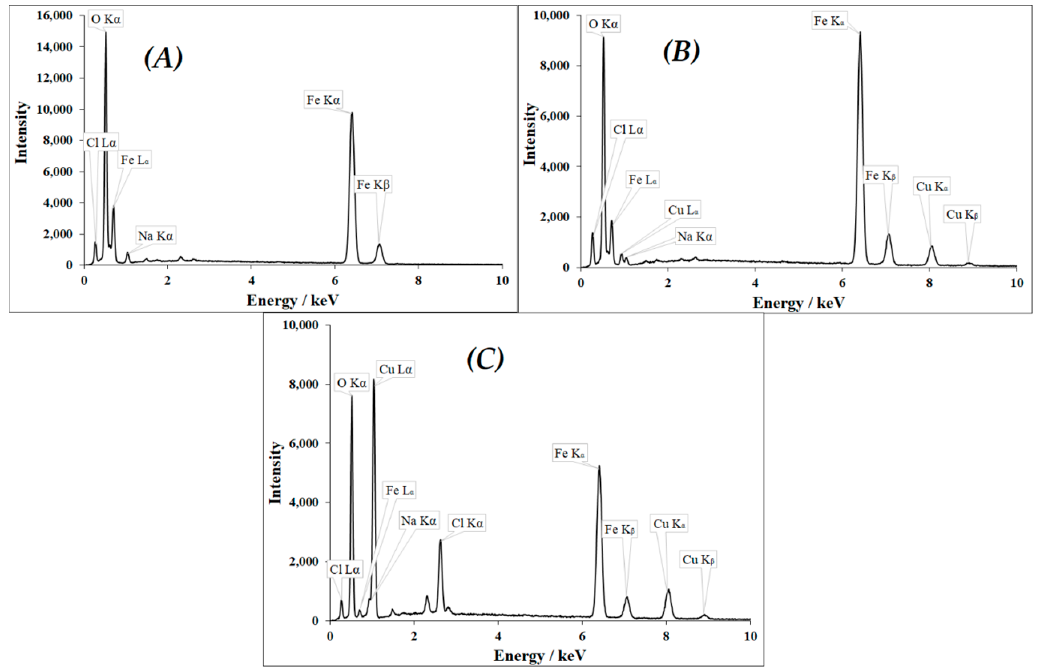
Figure 5. EDX spectra (recorded in scan mode) of doped ferrites ( A ) x = 0 NP-1 ( B ) x = 0.4 NP-3